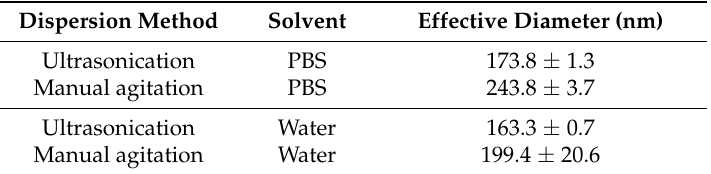
Table 2. Mean diameter for formulations of proliposome with xanthone 2 obtained by spray-drying (SD), prepared by different methods.